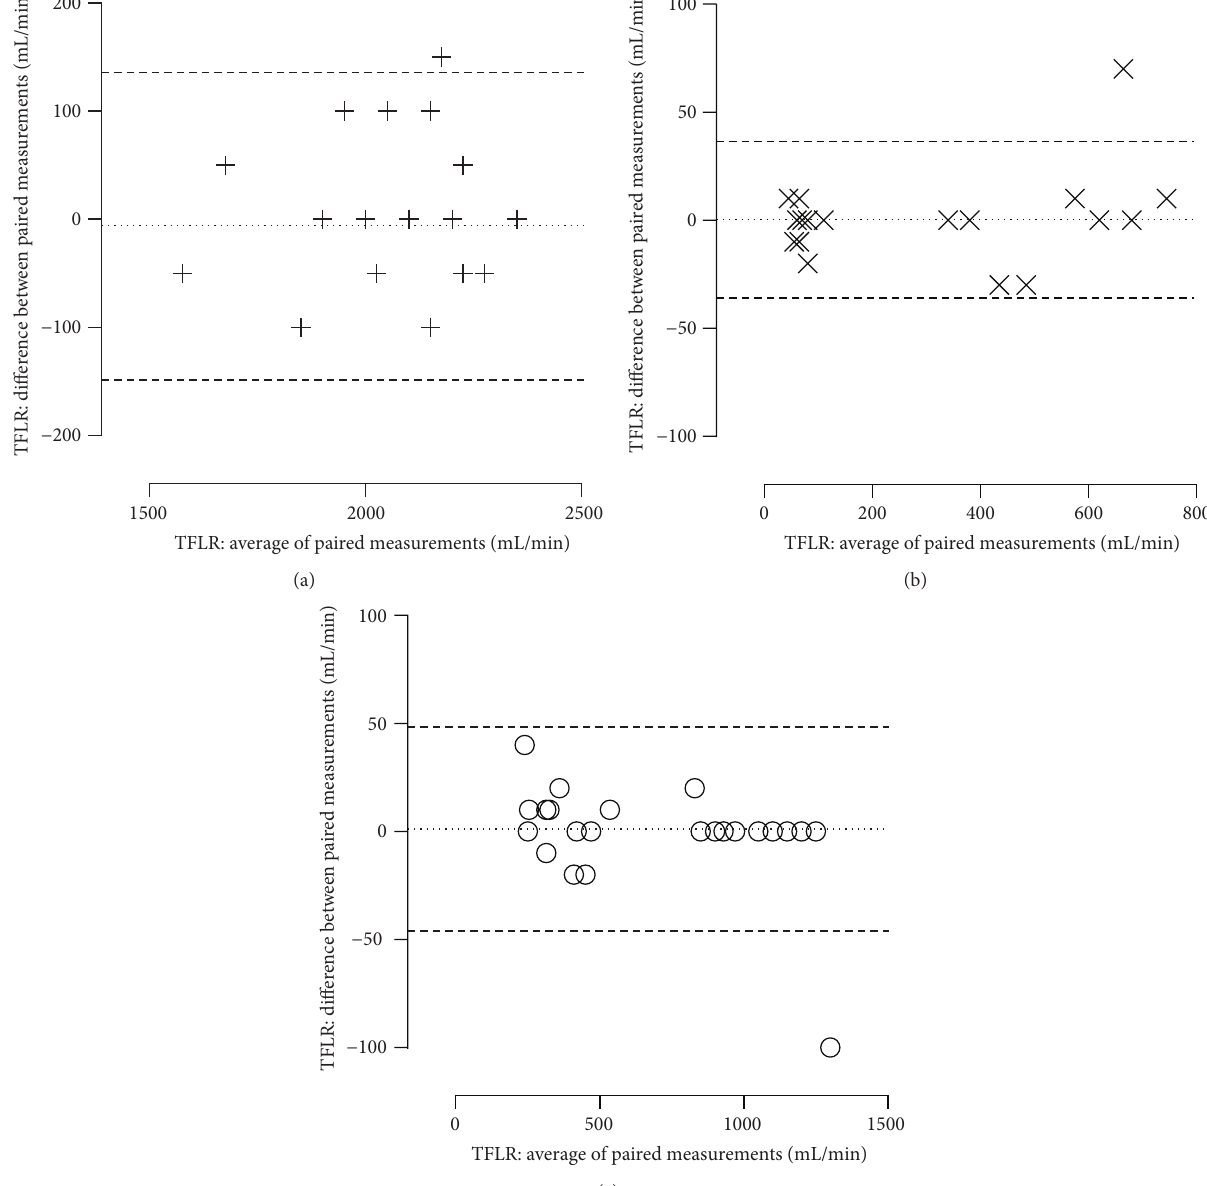
measurements differed by > 5% or volume measurements differed by > 5% and > 10 mL ⋅ min −1